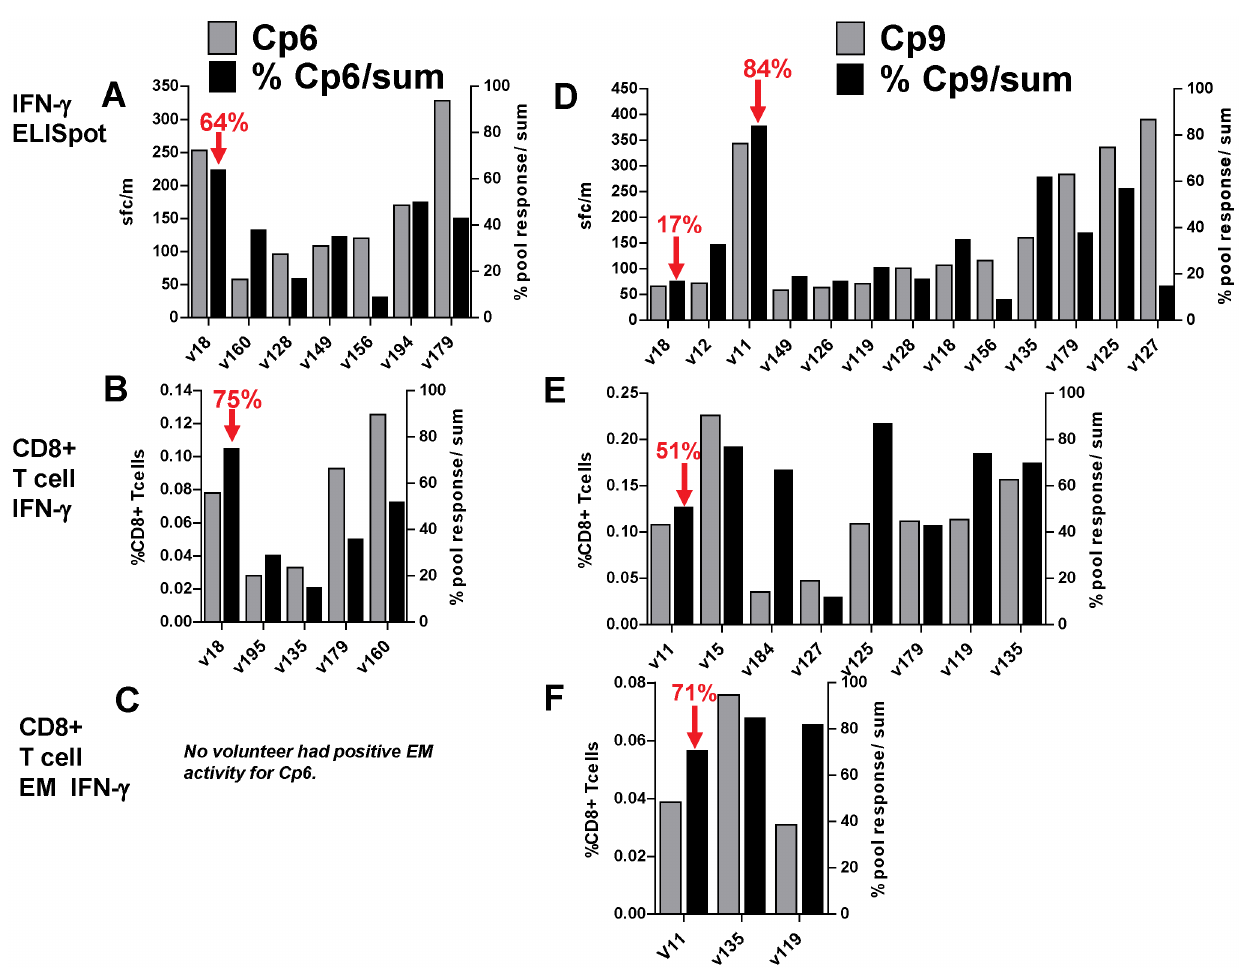
Figure 7. DNA/Ad and AdCA: Comparison of positive T cell activities and percent of total activities to CSP peptide pools. ELISpot, CD8 + T cell IFN- c , and CD8 + T cell EM IFN- c activities to individual CSP peptide pools (Cp6 and Cp9) were calculated as per cent of total activities of summed responses to all CSP peptide pools. All volunteers positive with Cp6 or Cp9 were selected. Panels A, B, C: Cp6: protected v18 had lower activities than some AdCA volunteers, but highest per cent activities; v194 (delay to patency) had higher per cent ELISpot activity than other AdCA volunteers, but lower than v18. None of the DNA/Ad or AdCA volunteers had positive EM activity to Cp6. Panels D, E, F: Cp9: protected v11 had highest per cent ELISpot activity to Cp9, but CD8 + T cell IFN- c and EM activities were lower than some AdCA